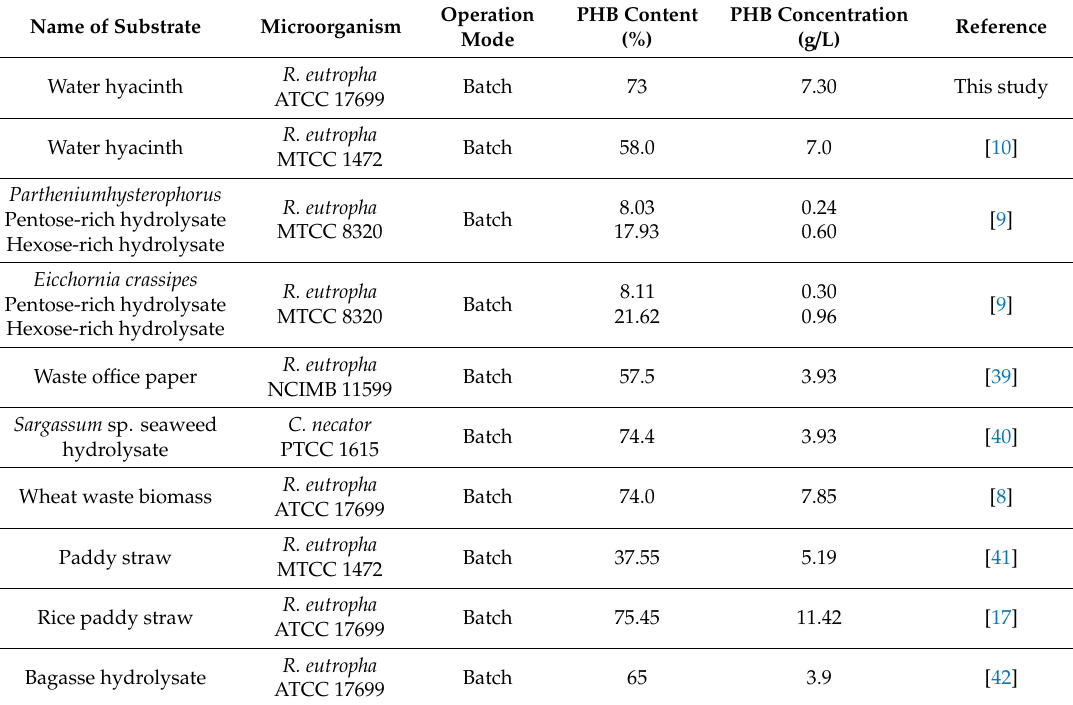
Table 4. Comparison of PHB accumulation and PHB production by Ralstonia eutropha strains using di ff erent biomass resources as a